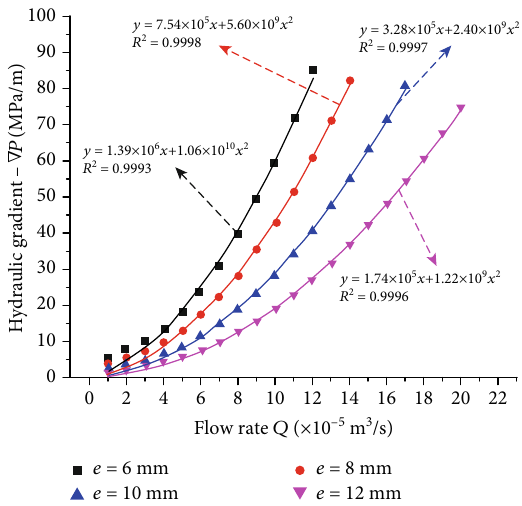
Figure 13: Variation of coe ffi cient A with fracture